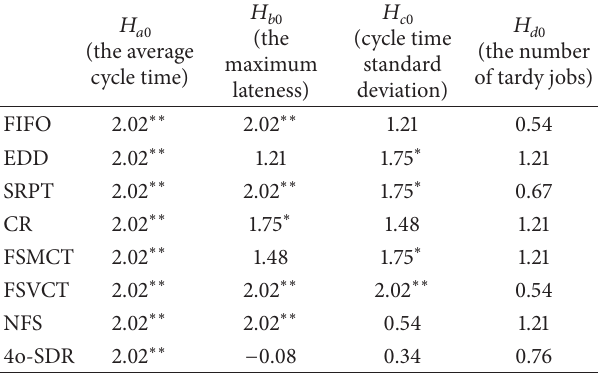
Table 8: Results of the Wilcoxon sign-rank